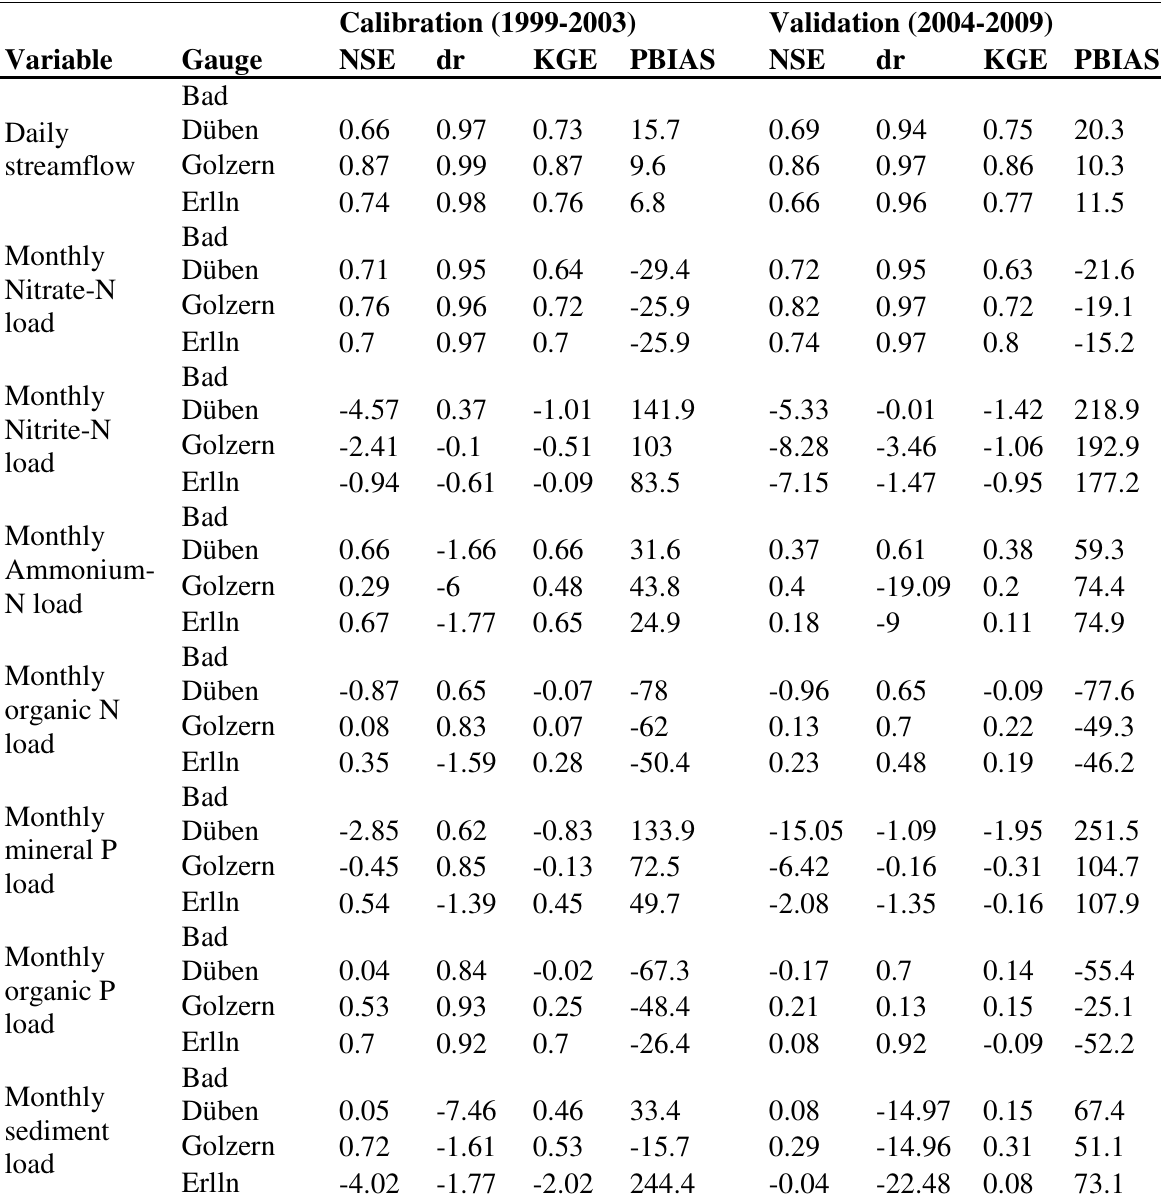
Table A1.1: Performance metrics for the Middle Mulde